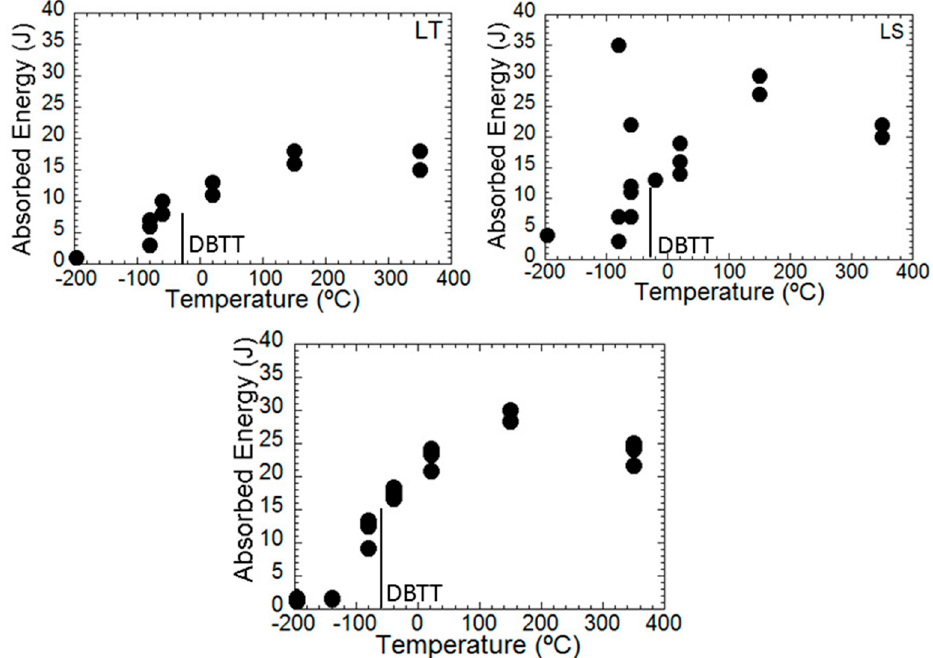
Figure 7. Variation with temperature of the U ‐ notch Charpy absorbed energy for ( a ) LT ‐ notched specimens of the PM2000 alloy; ( b ) LS ‐ notched specimens of the PM2000 alloy; and ( c ) the MA956 alloy. DBTT: ductile ‐ to ‐ brittle transition temperature. Table 3. Values of the parameters of the DBT curves.